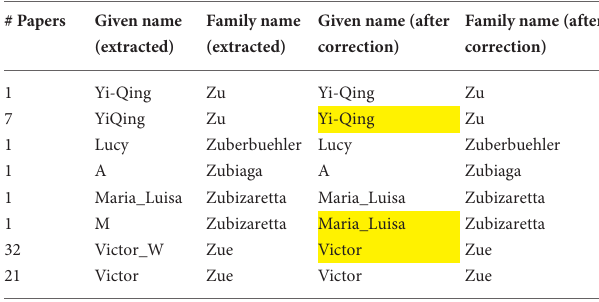
may drastically change their ranking (see the case of Victor Zue/Victor W. Zue, with 53 papers in total). This suggests a need to determine ways to uniquely identify researchers, which has been proposed (Joerg et al., 2012), and may also be solved through organisms, such as ORCID 8